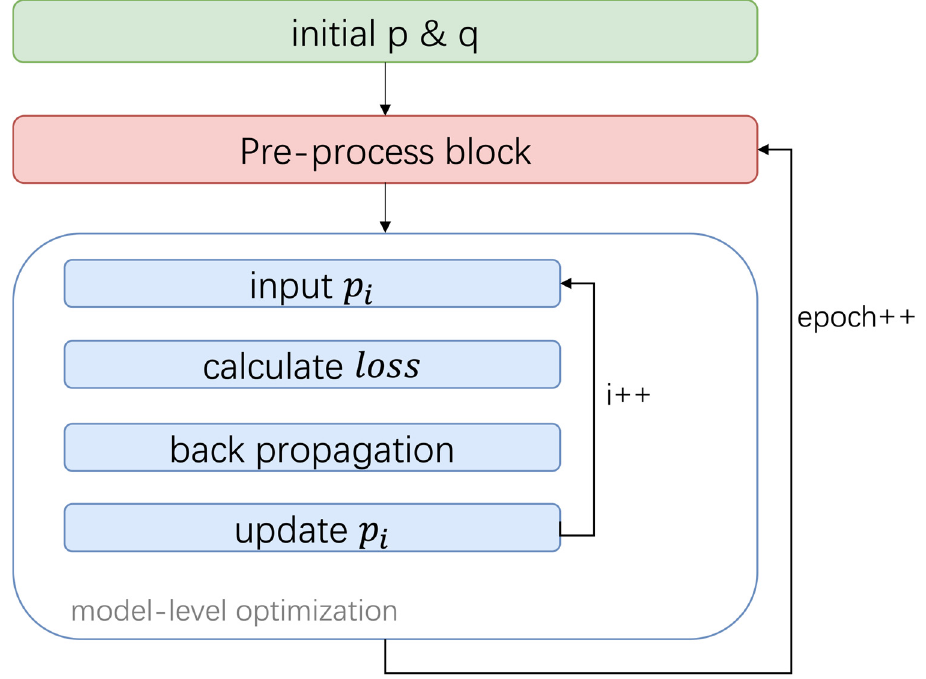
Figure 4. Pre-process Steps.